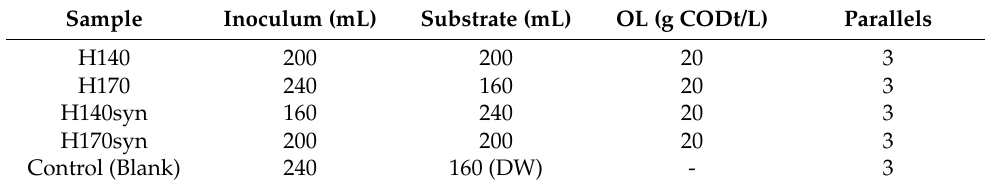
Table 2. Organic load (OL) of hydrolysates (real and synthetic) in an automatic methane potential testing system (AMPTS II)